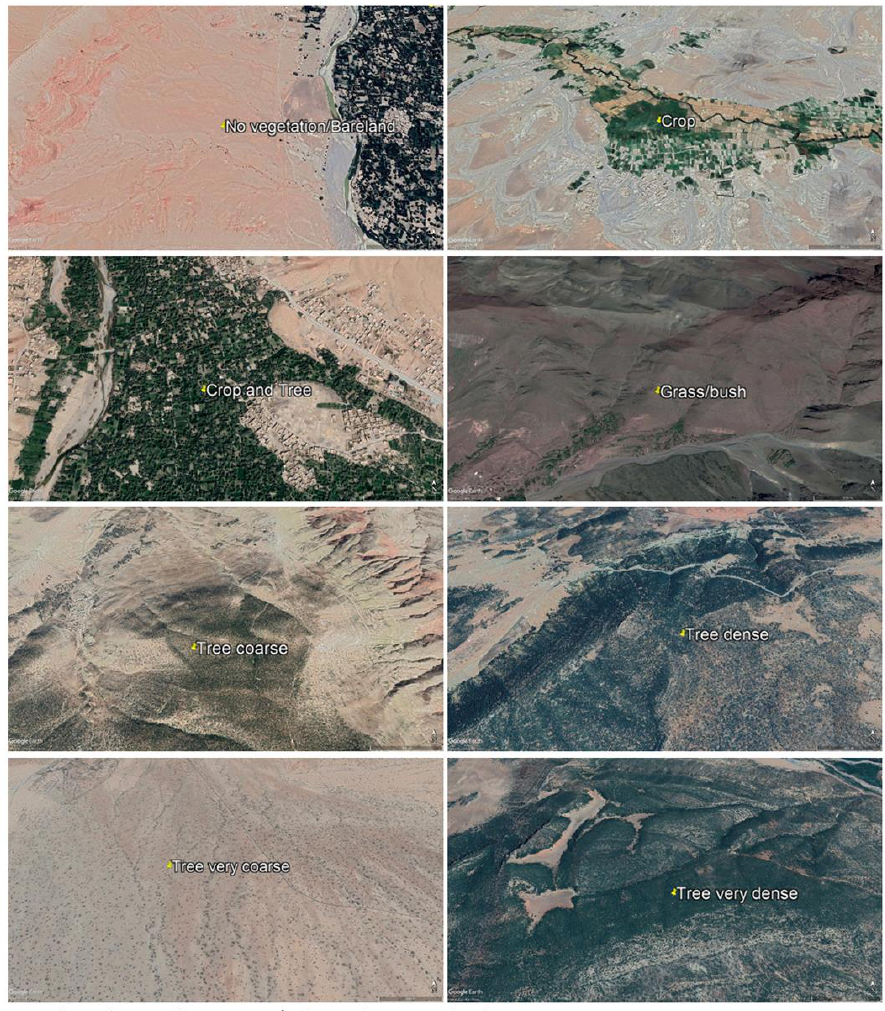
Figure 5. Eight vegetation types classified in the High Atlas Mountains of Morocco. The yellow points represent the location of ‘virtual ground truthing points’. All images were downloaded from Google Earth Pro7.1 in 2019 and 2020 at the same scale.